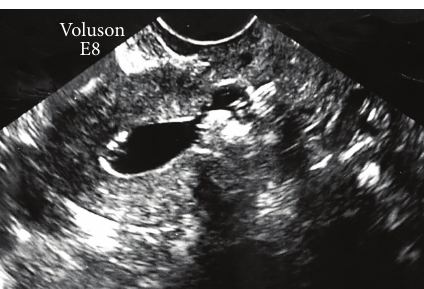
Figure 2: Eleven months after the cesarean section. When saline infusion sonohysterography was performed, physiological saline solution remained in the uterine cavity and did not flow into the vesicouterine pouch; expansion of the uterine lumen is evident.